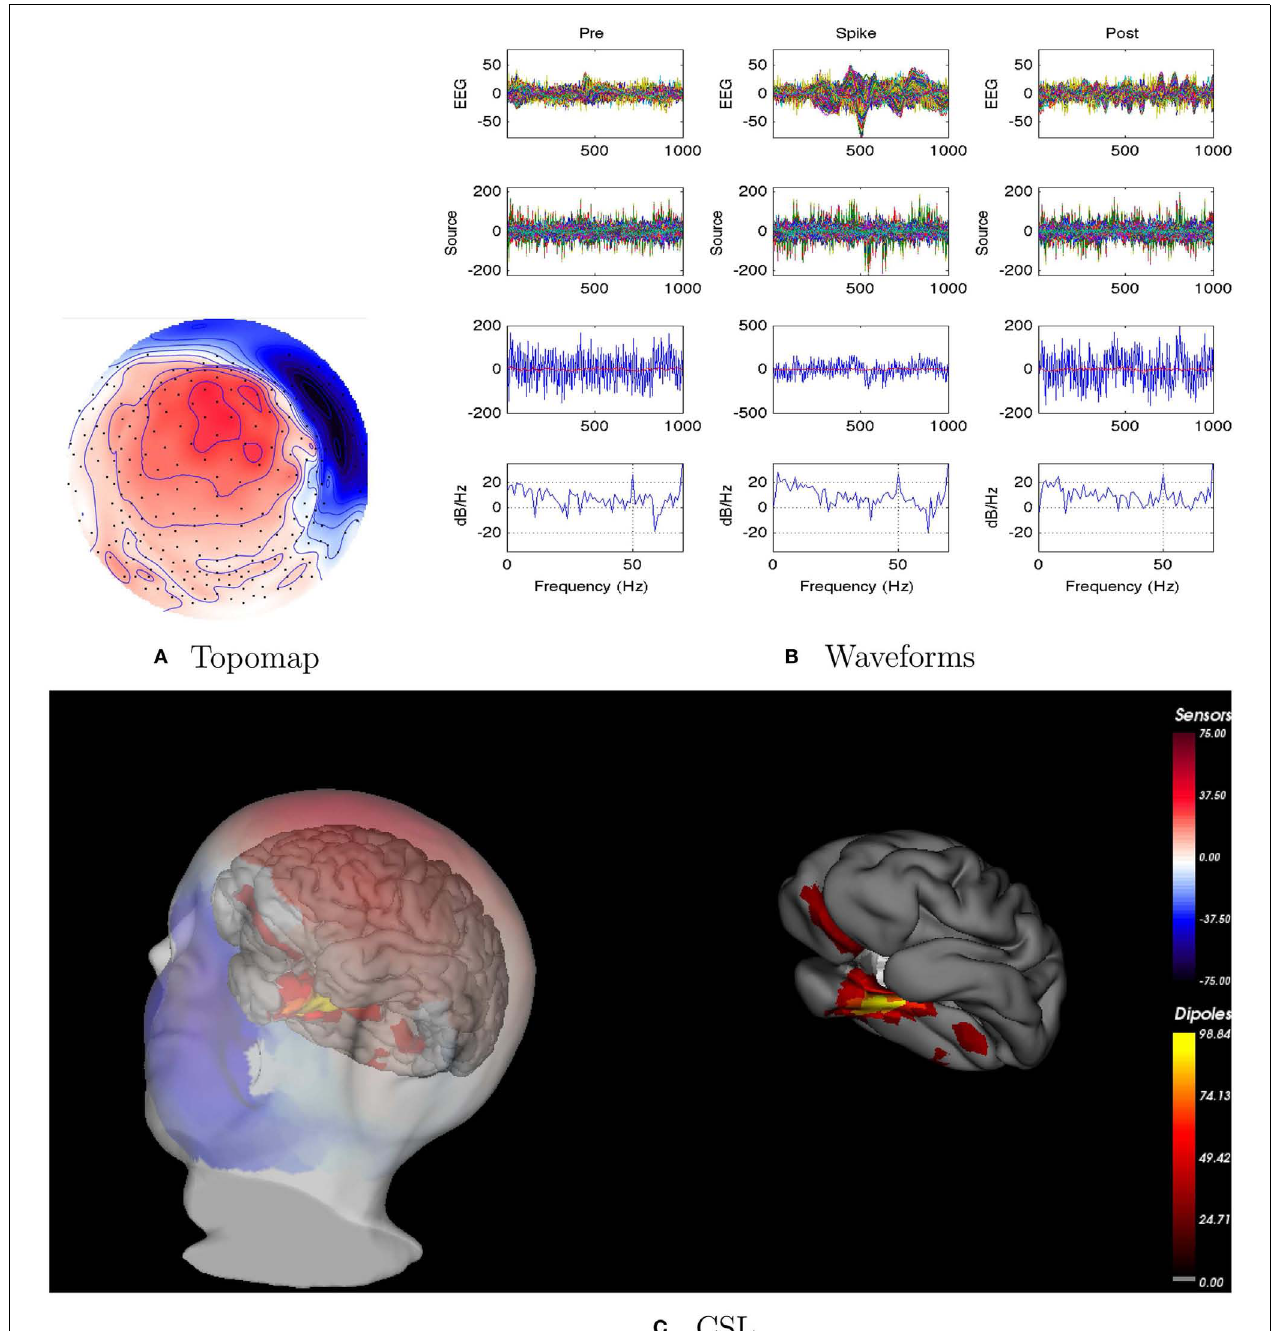
frequency spectra of the blue source waveforms (third row) shown in forth row. In (B) , each column represents 1s of data from a 3-s segment. Middle column represent data centered on the spike peak. (C) Electrical source localization with the patient’s individual electrical head model. Left: scalp potential reconstructed from the source estimate (at 50% of spike peak). Right: partially inflated brain illustrating the dominant source associated with the data illustrated in left figure (location of dipole described by blue trace in (B) , third row). Data was thresholded to only show top 5%